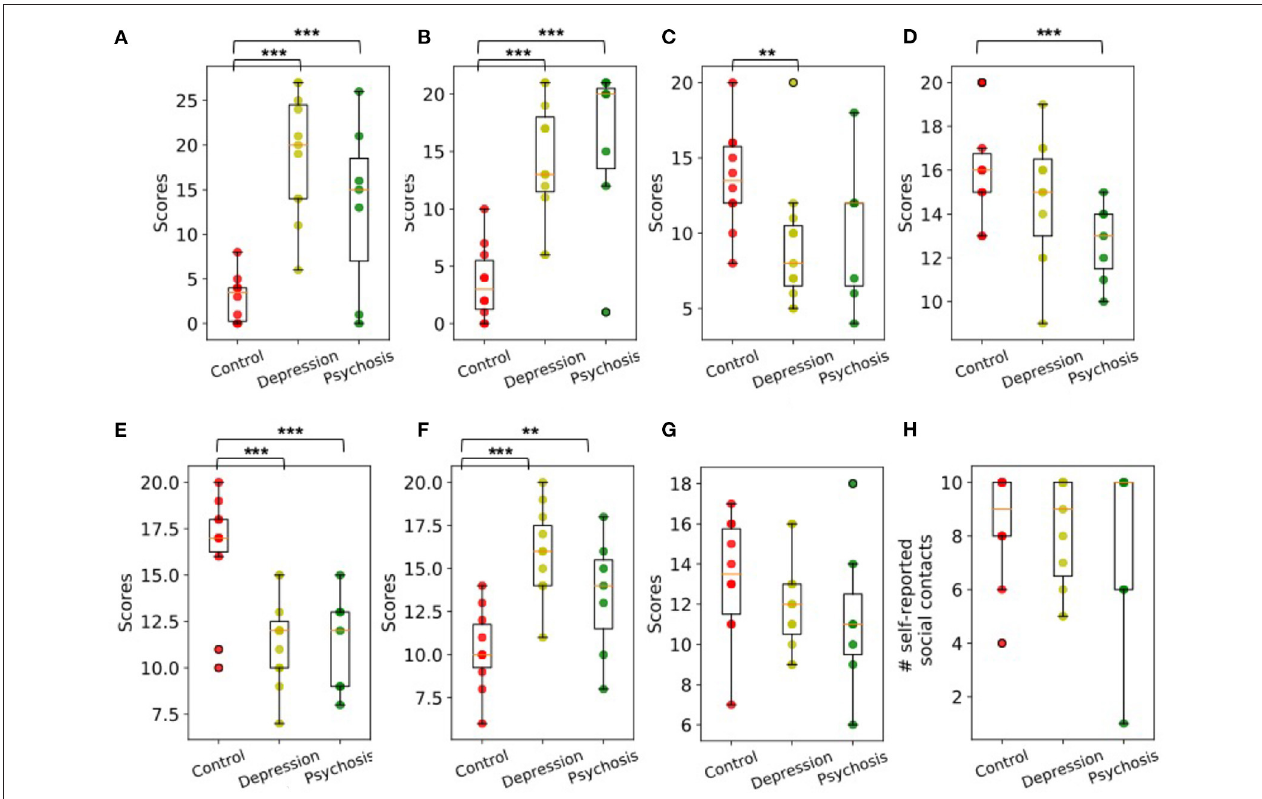
FIGURE 5 | The distribution of (A) PHQ-9, (B) GAD-7, (C) Extraversion, (D) Agreeableness, (E) Conscientiousness, (F) Neuroticism, (G) Openness, and (H) Number of self-reported social contacts for control, depression, and psychosis group. Group Differences are significant according to one-way ANOVA tests. The brackets show significant results with * p < 0.1, ** p < 0.05, and *** p <